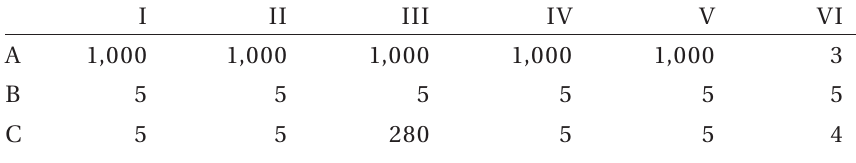
Table 2.3 Upper limit